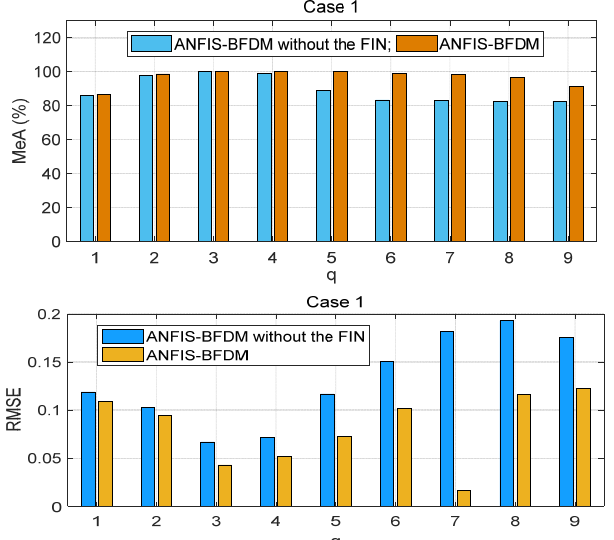
Figure 3. Deriving from the dataset “Case 1” (see Table 2)—the positive role of the filter FIN reflected via the MeA and RMSE of the ANFIS-BFDM in two cases, with/without r(t) when q (in Equation (16)) verifying from 1 to 9.